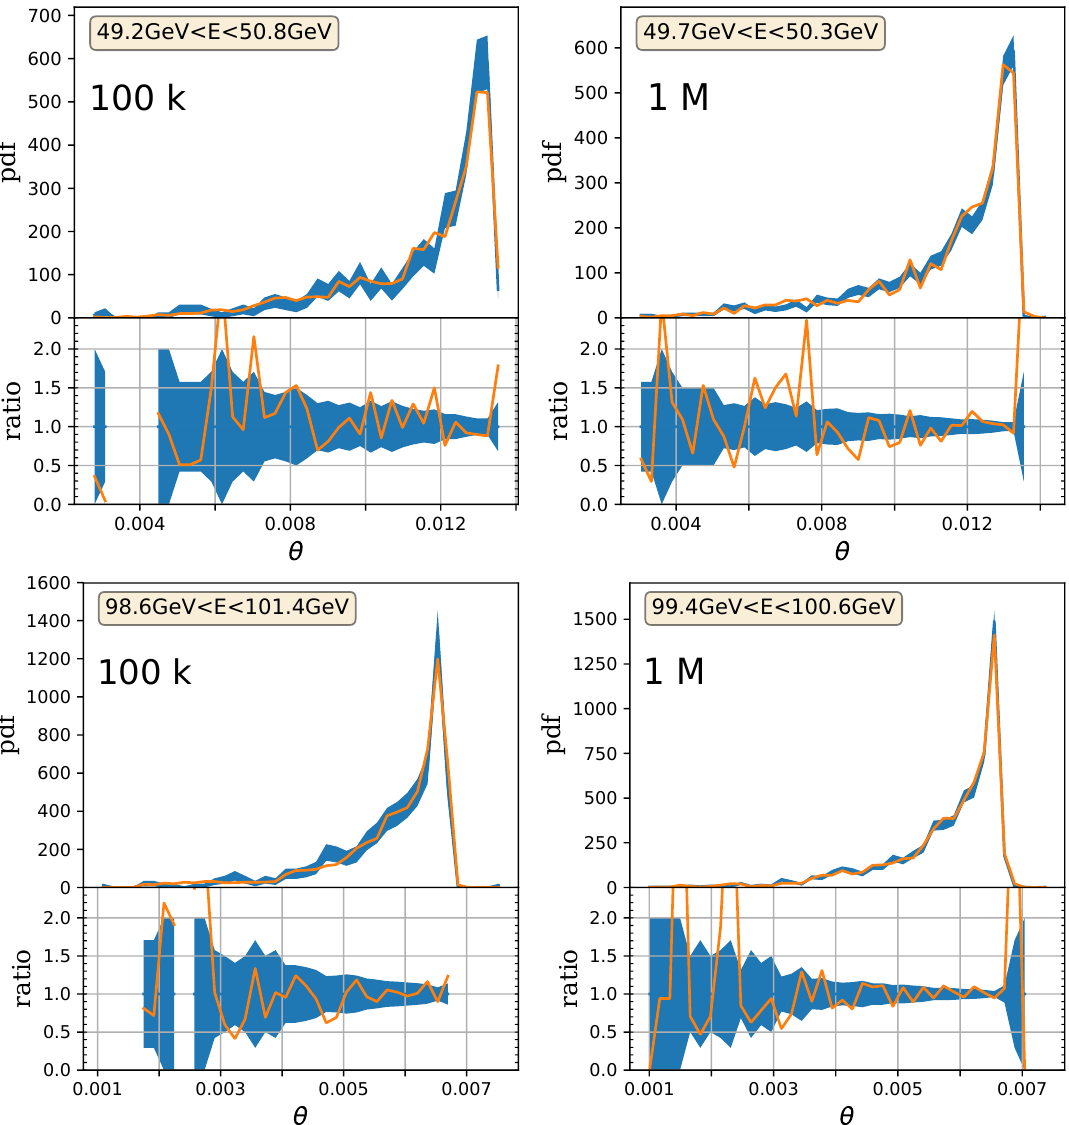
Figure 15. Normalized angular (cid:18) -distributions for di(cid:11)erent energy bins for the case of 100 k inputs events (left panels) and of 1 M inputs events (right panels). The blue band represents the original data with the associated Poissonian uncertainties. The orange line represents the histogram of the points regenerated with the 2D mesh. The energy bins size is automatically determined by MadDump in a such a way to have comparable amount of statistics in each